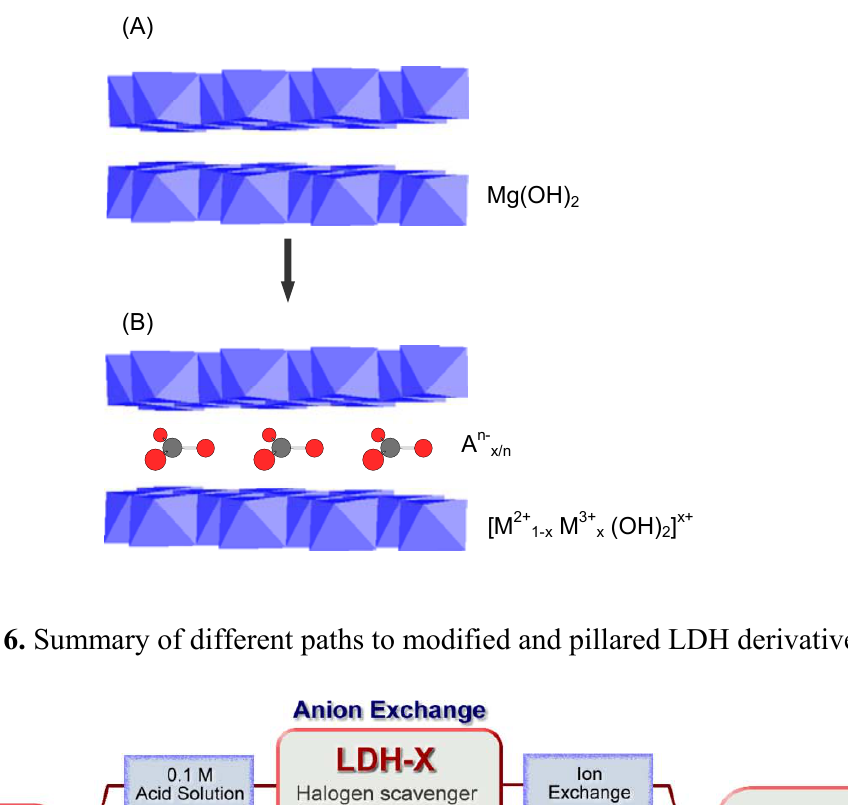
Figure 5. Schematic representation comparing the crystal structure of brucite (A) and LDH (B).